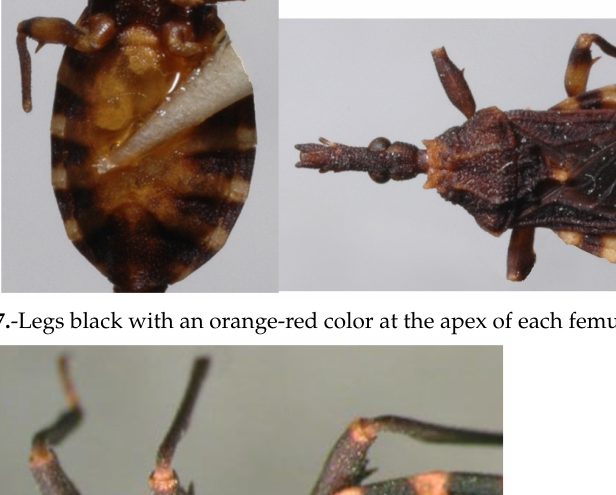
-Pronotum without posterior and lateral border light colored. Scutellar process sulcate. Membrane of hemelytron dark. Ventral area of abdomen mainly yellow with black stripes. Hind femora yellow in central two-thirds